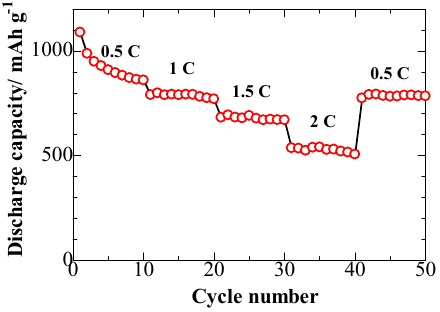
Figure 7. Rate performance of S/Mn 3 O 4 cathode.